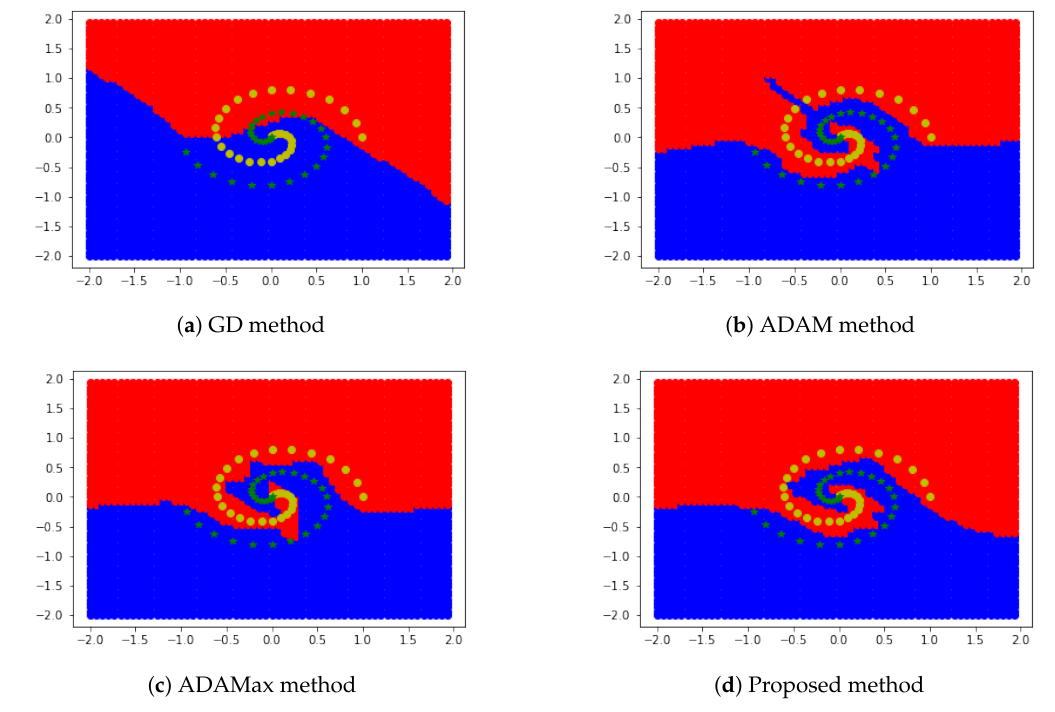
Figure 12. comparing proposed scheme with other